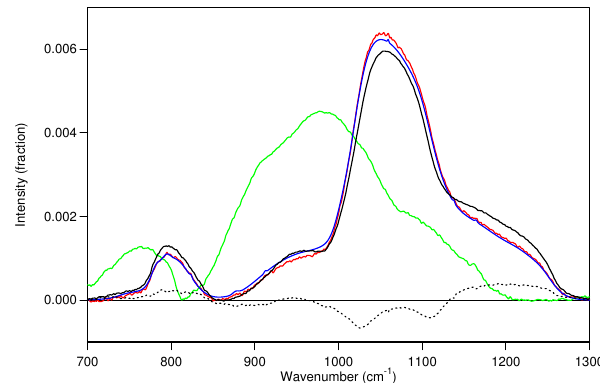
Fig. 3. Example of a Baikal diatom sample (#36) fitted against the BFC mod – “Silt” mass-balance matrix. Red line=BFC mod spectra, Green line=“Silt” spectra, Black line=Baikal sample #36 spectra; Blue line=optimum, best fit, modelled spectra for sample #36 in the BFC mod – “Silt” matrix; Dashed line=residual spectra from the fitting of the #36 spectra against the modelled spectra. For #36 XRF contamination=6.1%, FTIR